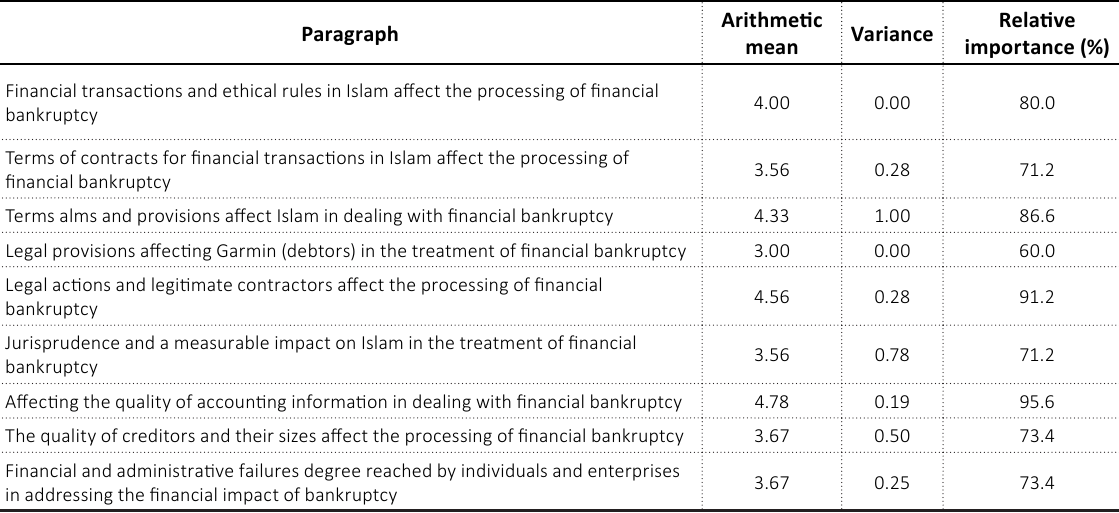
Table 5. Average contrast and the relative importance of the dependent variable “financial bankruptcy from an Islamic perspective” Paragraph Arithmetic